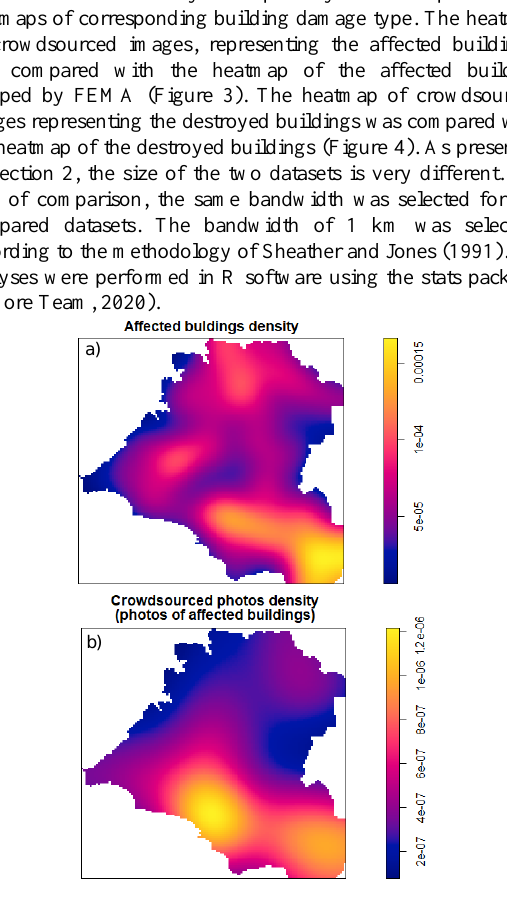
Figure 3. Kernel density heatmap for 1 km radius for a) affected buildings b) crowdsourced photos of affected buildings